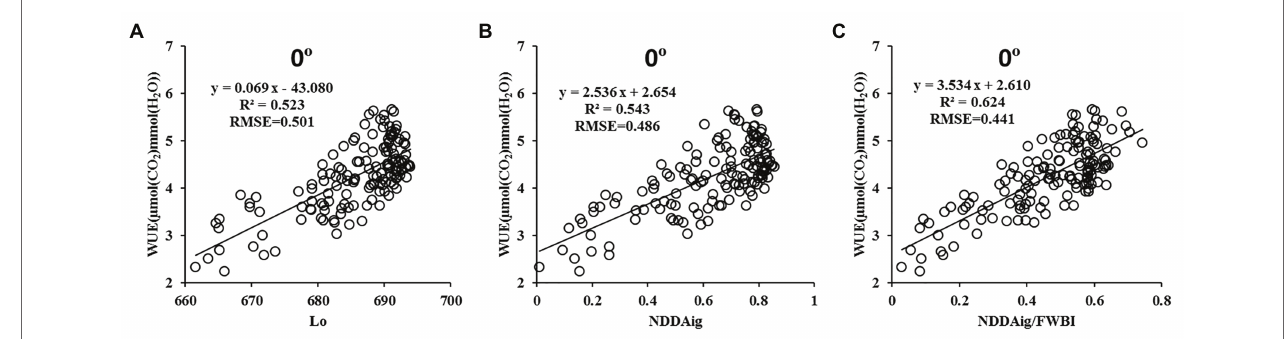
FIGURE 5 | Relationships between Lo (A) , NDDAig (B) , NDDAig/FWBI (C) , and the WUE at a 0 ° zenith angle ( n =